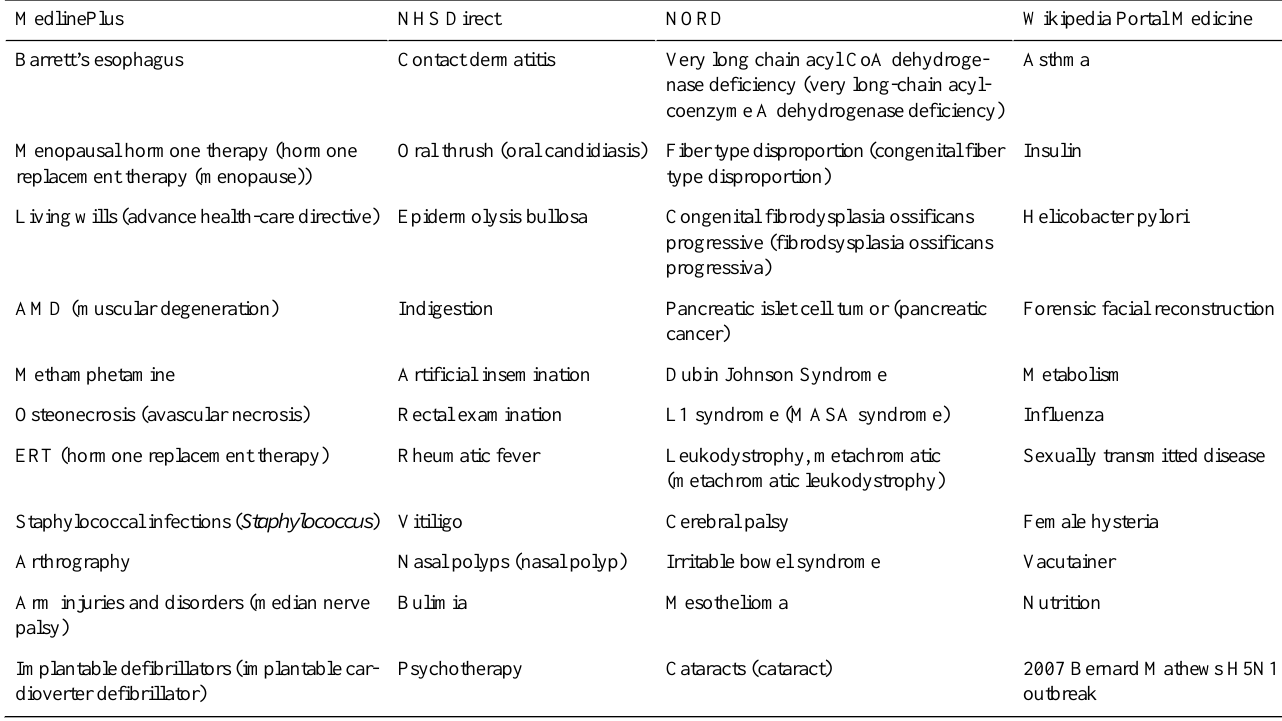
Table 1. The sampled articles list for each of the medical databases and Wikipedia Portal Medicine. For the first 3 columns, the first term is the keyword phrase selection, whereas the bracketed term refers to the Wikipedia article name if it was not the